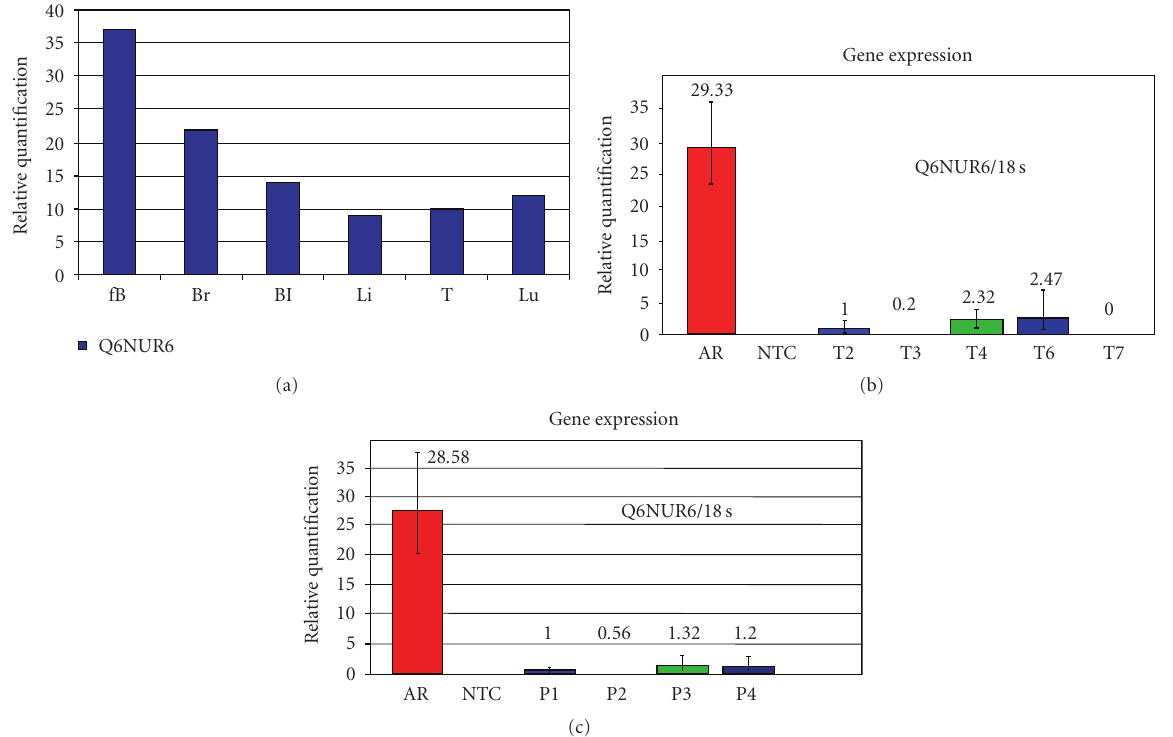
Figure 2: Quantitative expression of Q6NUR6 gene. (a) The expression pattern of the Q6NUR6 gene in various human tissues, fB: fœtal brain; Br: brain; Bl: blood; Li: liver; T: testis; Lu: lung. (b, c) Quantitative Expression of Q6NUR6 gene in the patient and controls. QRT- PCR was done on RNA extracted from blood cell lines. A significantly higher expression level was detected in the patient compared with normal control individuals (b) and with autistic patients without chromosomal anomalies (c). The expression normalization was done using the ribosomal 18S gene. (AR: Patient; NTC: No Template Control; T2, T3, T4, T6, T7: Healthy control individuals; P1, P2, P3, P4: autistic patients without chromosomal